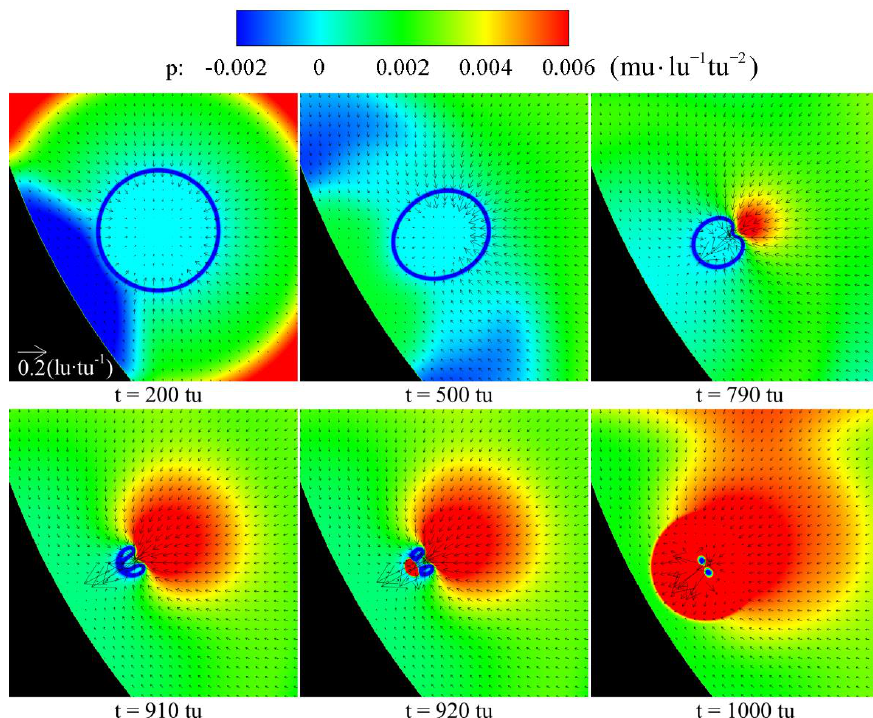
Figure 11. Pressure field and velocity field of cavitation-bubble collapse for Case 6.